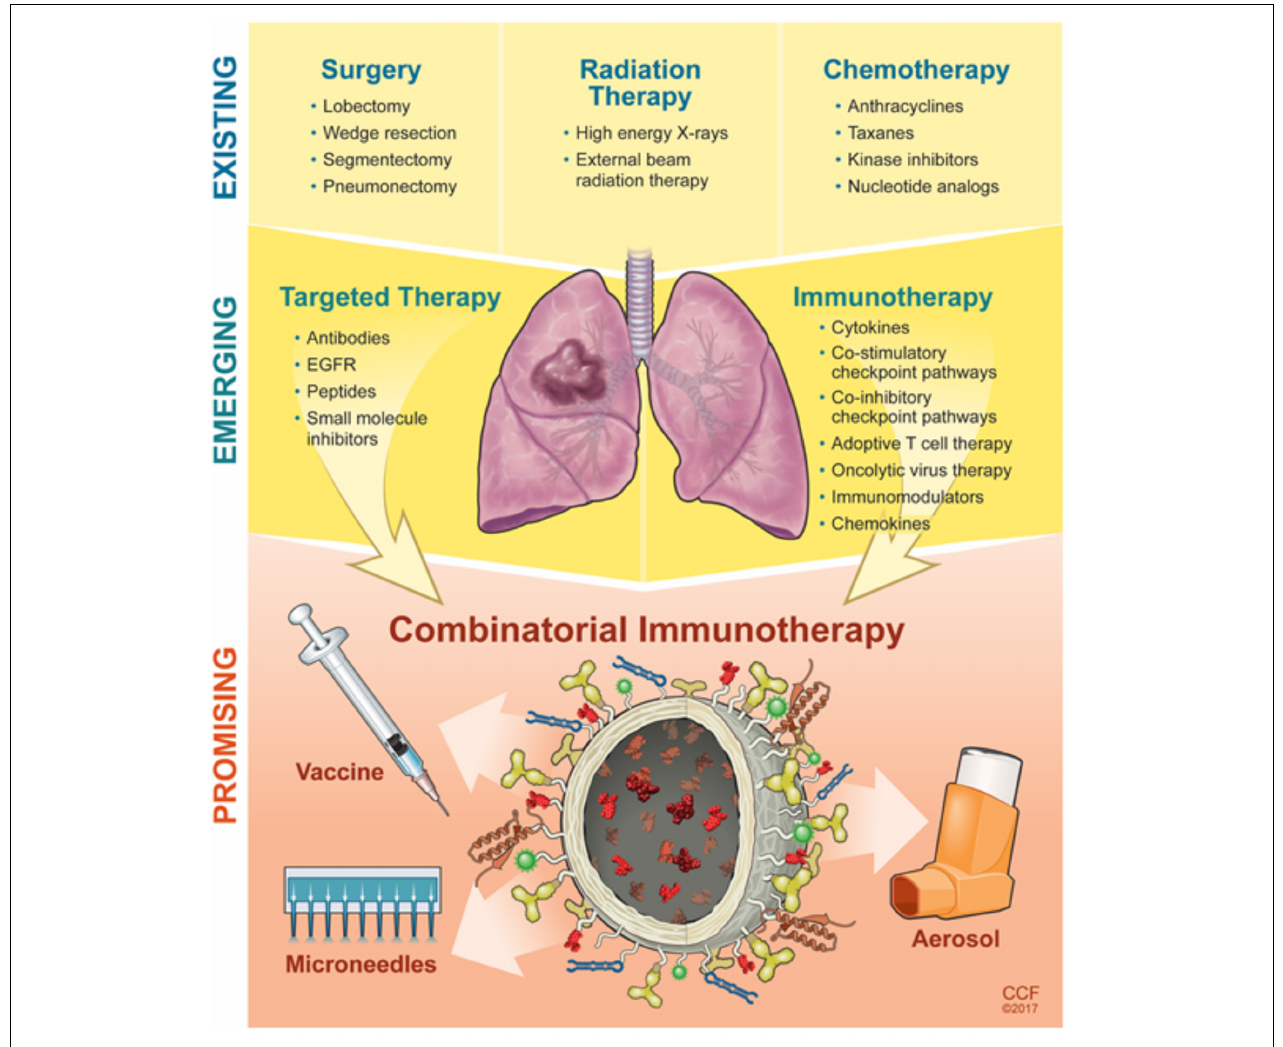
FIGURE 3 | Evolution and progress of next-generation strategies to modulate the lung